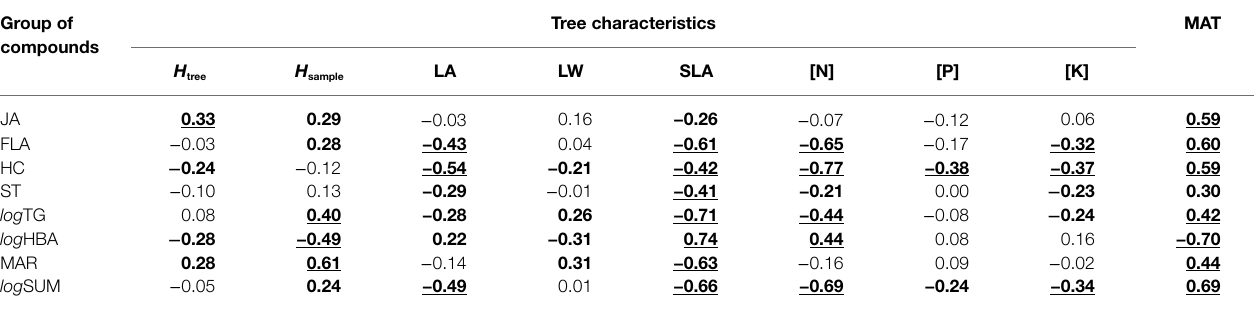
TABLE 2 | Linear correlations between the secondary metabolite contents in leaves, sample tree characteristics and mean annual temperature. Group of Tree characteristics MAT compounds H